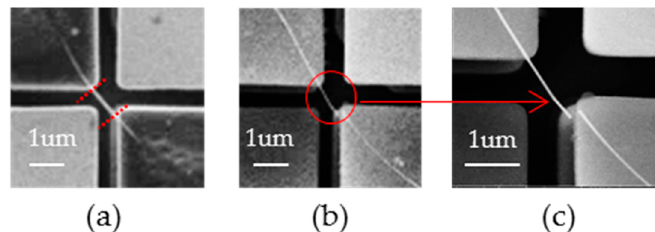
Figure 6. A Ag Nanowire with ~100 nm diameter has fractured after cyclic torsional loading: ( a ) shows the nanowire before the test. ( b ) shows the sample right after torsional fatigue failure after ~432,000 cycles. Note that the difference in contrast for the bonding points in (a) and (b) was due to the different electron beam voltages we used for SEM imaging the sample. We intentionally used low e-beam voltage (2 kV) for quantifying the boundary of clamping points in (a), while the bonding points appeared more “transparent” under high electron beam voltage (10 kV) in (b) and (c). ( c ) shows the close-up view of the fractured nanowire after stopped the test.